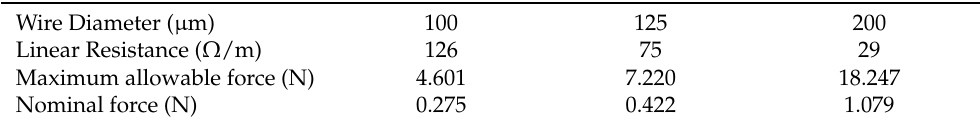
Table 3. General properties of SMA